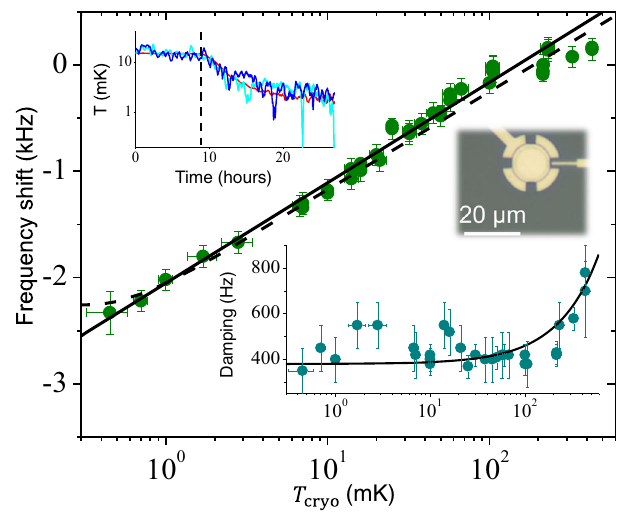
Fig. 1 Mechanical properties versus temperature. Main graph: mechanical mode frequency shift ( ω m [ T ] − ω 0 )/(2 π ) (with respect to ω 0 /(2 π ) ≈ 15.1MHz) as a function of cryostat temperature. The black line is a simple Logarithmic fi t, whereas the dashed line is the full theoretical fi t function (see text). An optical picture of a device from the same batch is also shown. Bottom inset: corresponding mechanical damping Γ m /(2 π ). The black line is a linear fi t (see text). Top inset: measured temperatures at beginning of cooling in a demagnetisation process (starting at the dashed vertical). The red curve corresponds to the cryostat T cryo , whereas the two blue curves are mechanical mode temperatures T mode calculated from the spectrum (from two distinct runs, see text). Error bars correspond to type A uncertainties extracted from the fi tting process (Supplementary Note